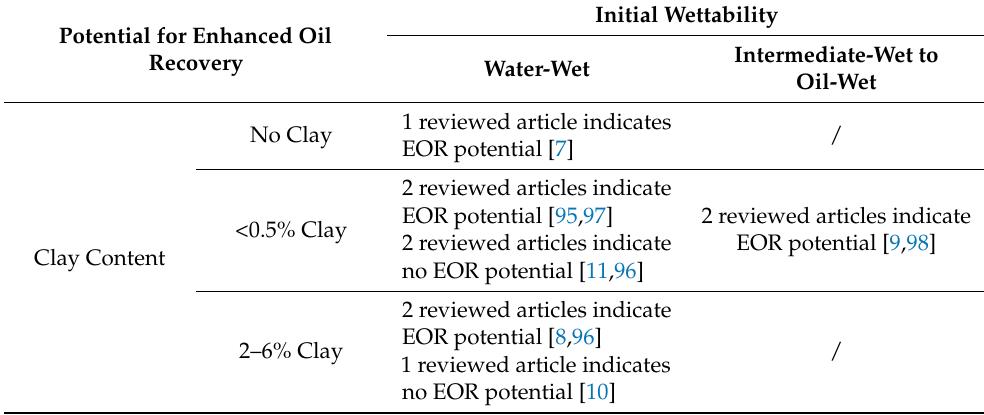
Table 9. Summary of CO 2 LSWAG injection EOR potential from core flooding